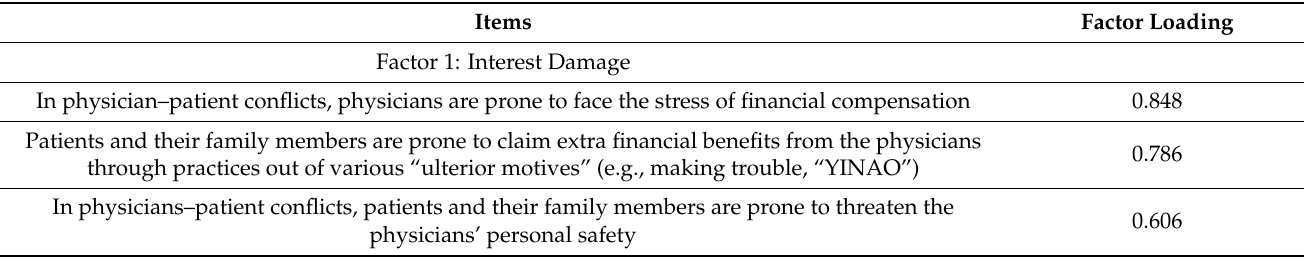
Table 2. Rotated component matrix of all